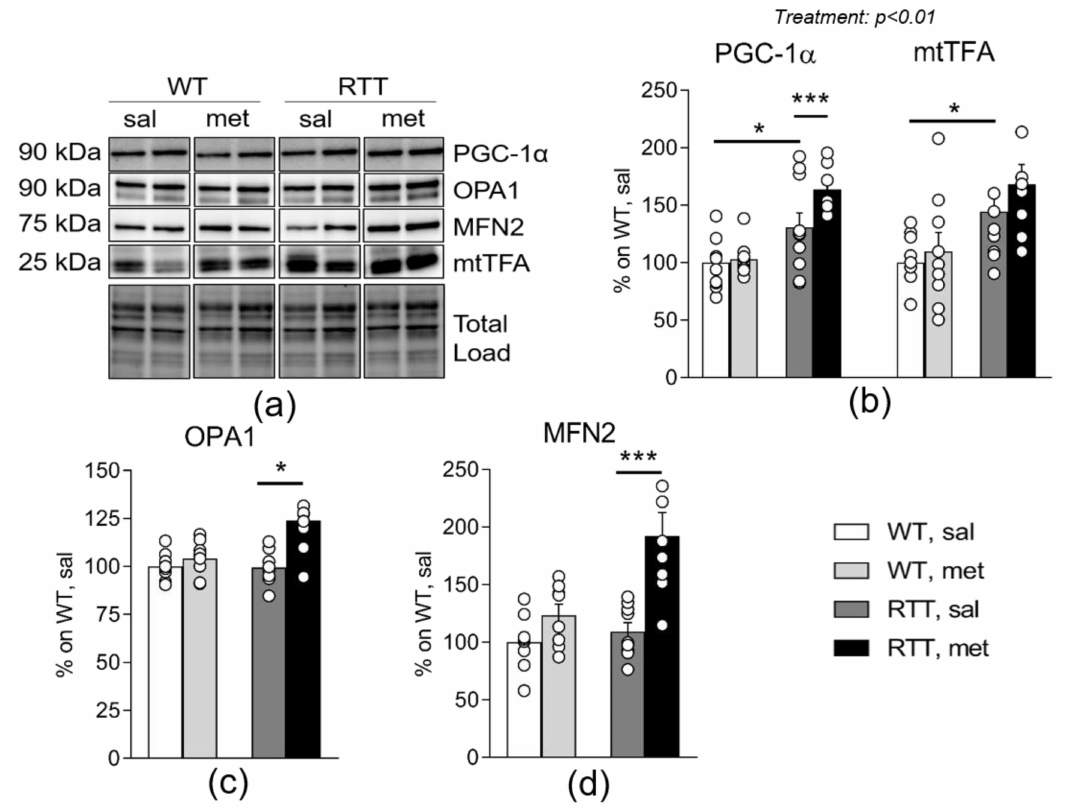
Figure 5. Metformin systemic treatment boosts pathways related to mitochondrial biogenesis and remodeling in RTT mouse brain. PGC-1 α protein expression and the levels of its downstream target mtTFA are increased in RTT mouse hippocampus compared to WT controls ( b ). Metformin treatment exacerbates this genotype di ff erence. Following metformin treatment, RTT mouse hippocampus shows an increase in mitochondrial biogenesis related protein OPA1 ( c ) and MFN2 ( d ). Representative